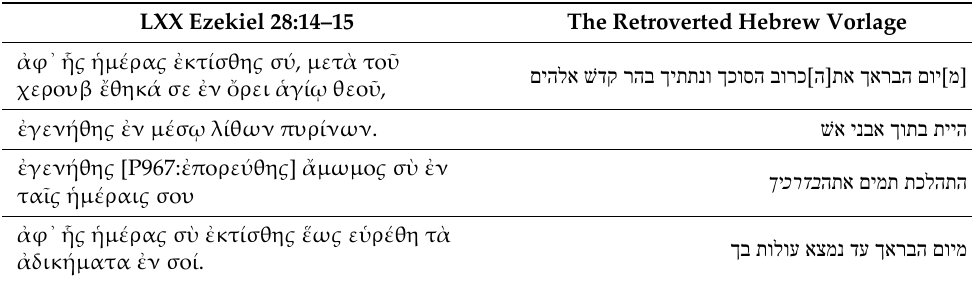
Table 2. Retroversion to the Hebrew Vorlage according to the LXX Translator’s Perception. LXX Ezekiel 28:14–15 The Retroverted Hebrew